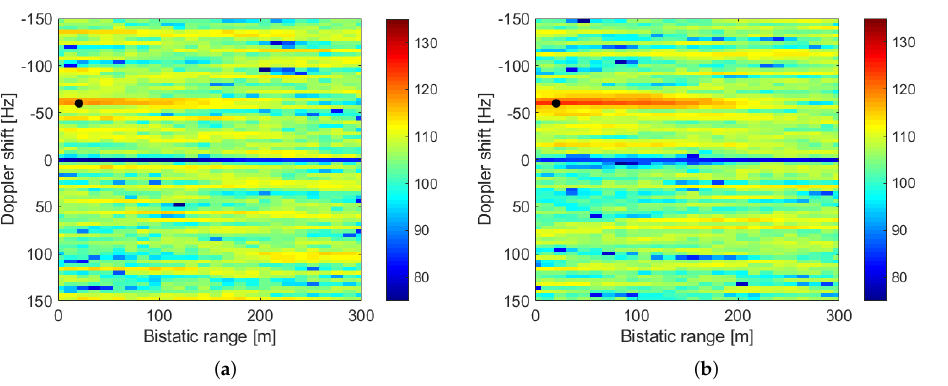
Figure 11. Real radar data results: first stage spatial filtering. ( a ) RDM from single array element. ( b ) RDM after beamforming (12.5 ◦